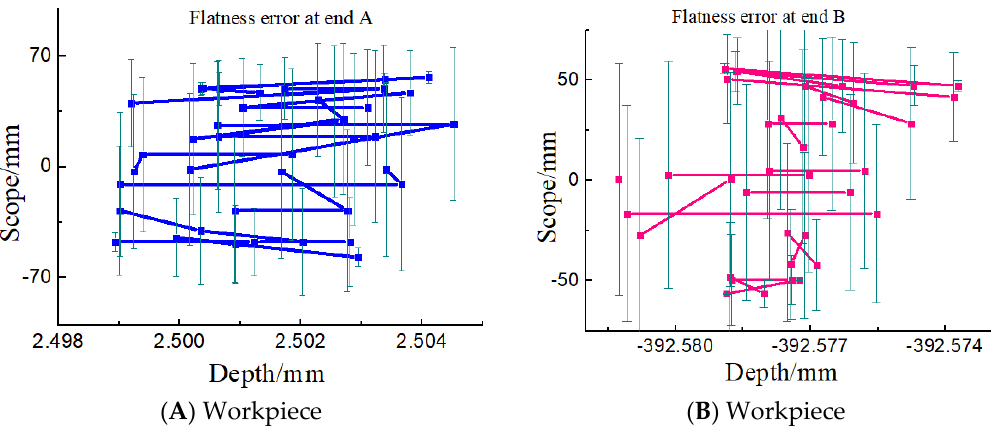
Figure 9. Three-time test data diagram of workpiece B end. ( A ) First test, ( B ) second test, and ( C ) third test.